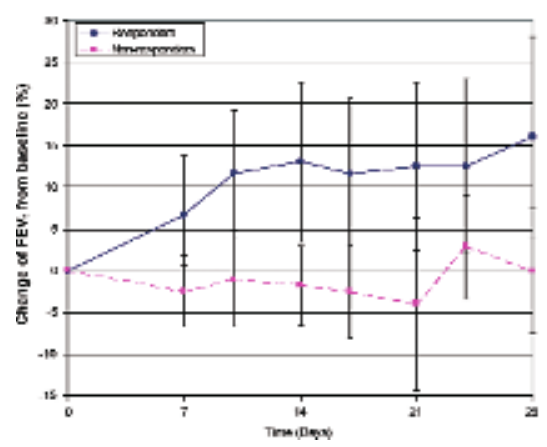
Figure 3 Change of postbronchodilator FEV 1 from baseline in percent during oral corticosteroid trial. Mean ± 95% confidence interval. FEV 1 = forced expiratory volume in 1 second. Responders n = 17; non-responders n = 13.